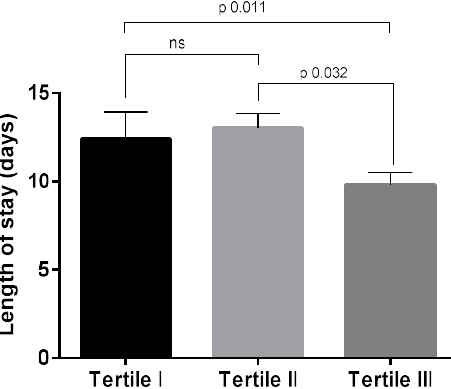
Figure 1. Length of stay in hospitalized elderly patients enrolled in this study and stratified according to the mini nutritional assessment at admission in well-fed (WF, N = 65), at risk of malnutrition (RM, N = 84), and malnourished (M, N = 45). Data are expressed as mean ± SEM. Statistical differences were assessed by one-way ANOVA and Tukey as post hoc test. p Values < 0.05 were considered statistically